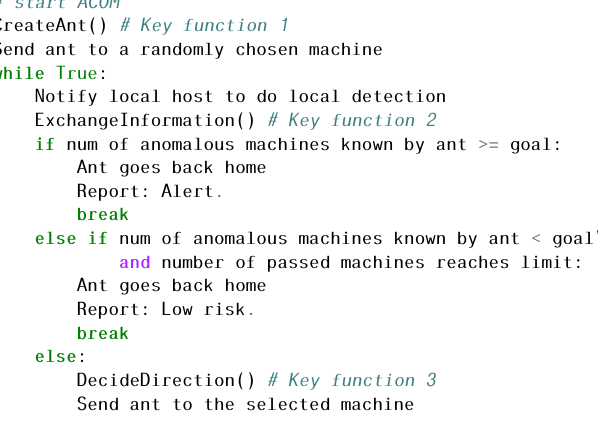
Figure 5. Pseudo code describing the work procedure of